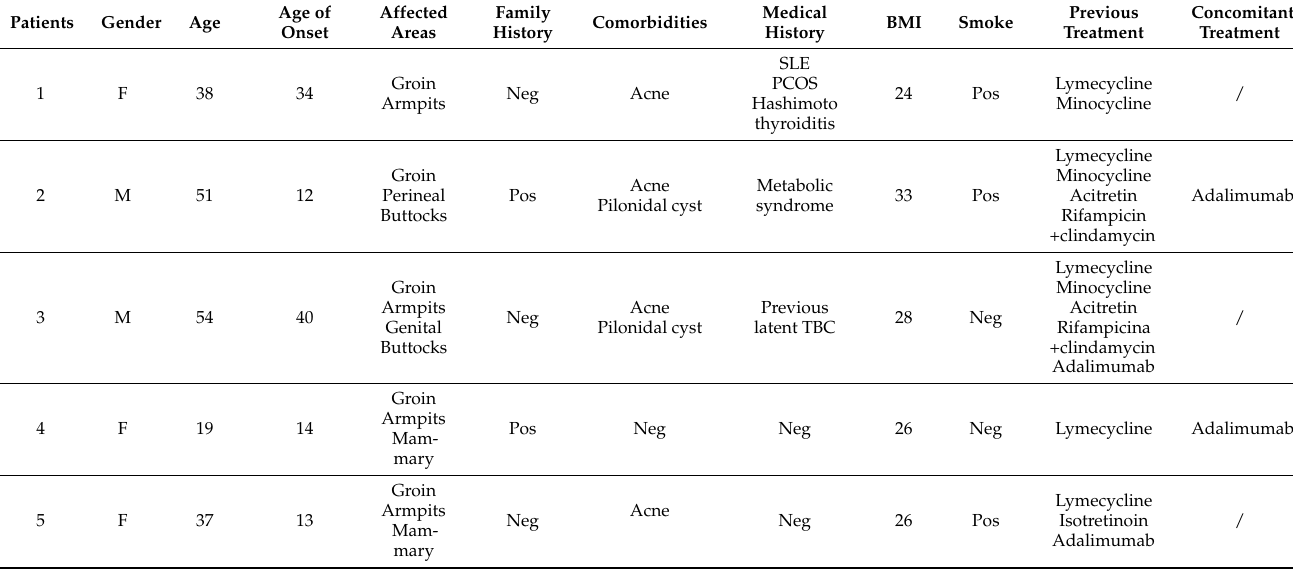
Table 1. Demographic and clinical characteristics of HS